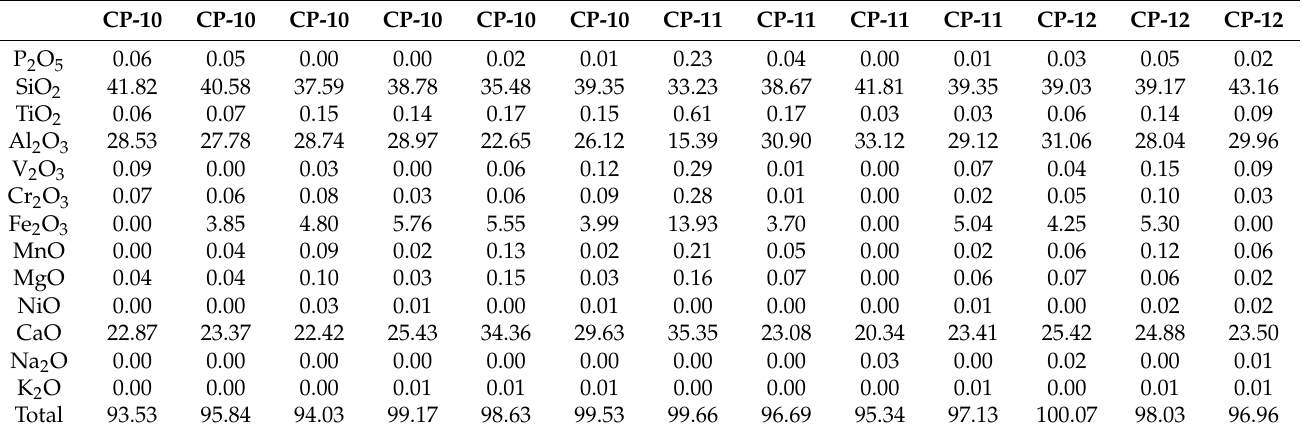
Table 4. Electron microprobe analyses (in wt.% of oxides) of the clinozoisite breakdown products (bulk from area with 5 µ m